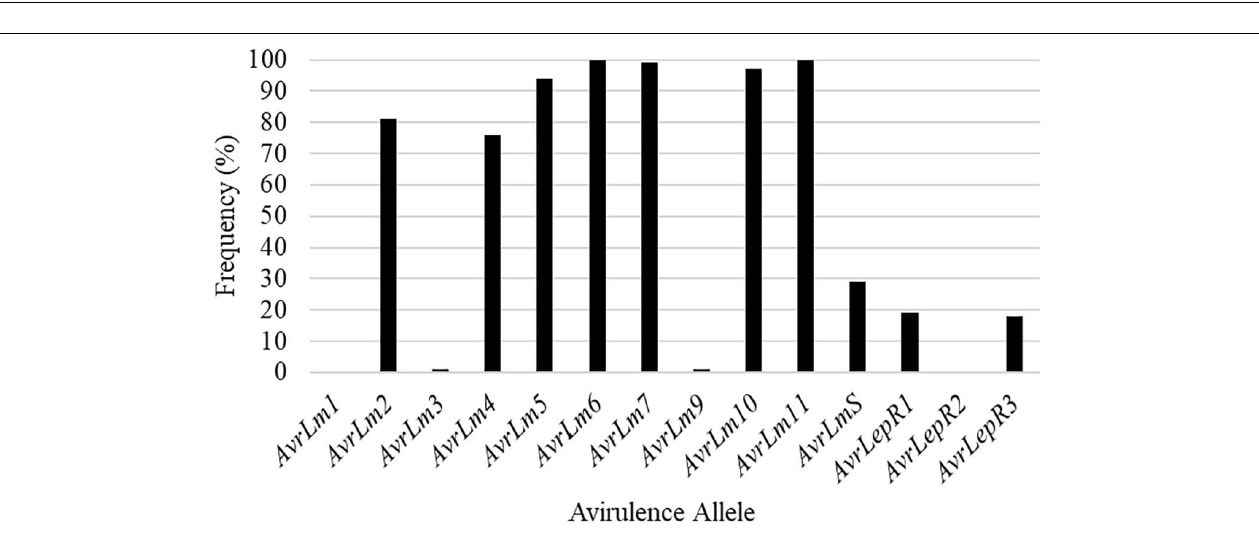
FIGURE 2 | The frequency of avirulence alleles in the Leptosphaeria maculans population from 22 isolates collected in the spring of 2018, from a 2016 canola residue, prior to seeding Saskatchewan field SK1 in 2018.